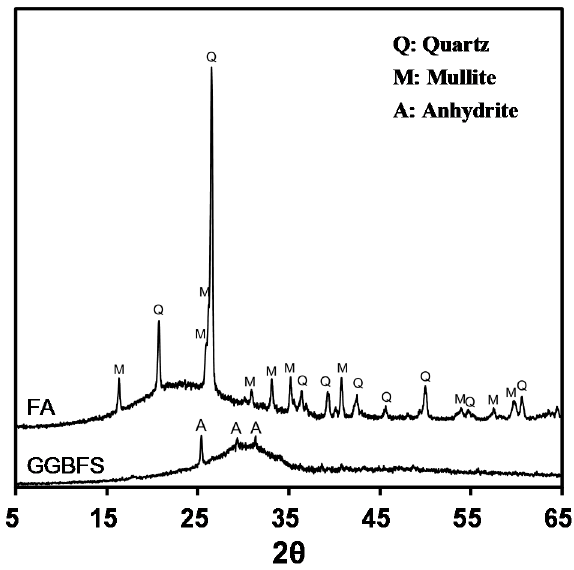
Figure 1. X-ray di ff raction patterns of FA and Figure 1. X-ray diffraction patterns of FA and GGBFS.